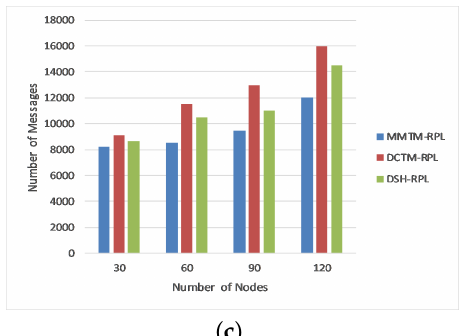
Figure 6. Comparison of control message overhead for different attacks: ( a ) Rank attack, ( b ) Sybil attack, and ( c ) Sinkhole attack.